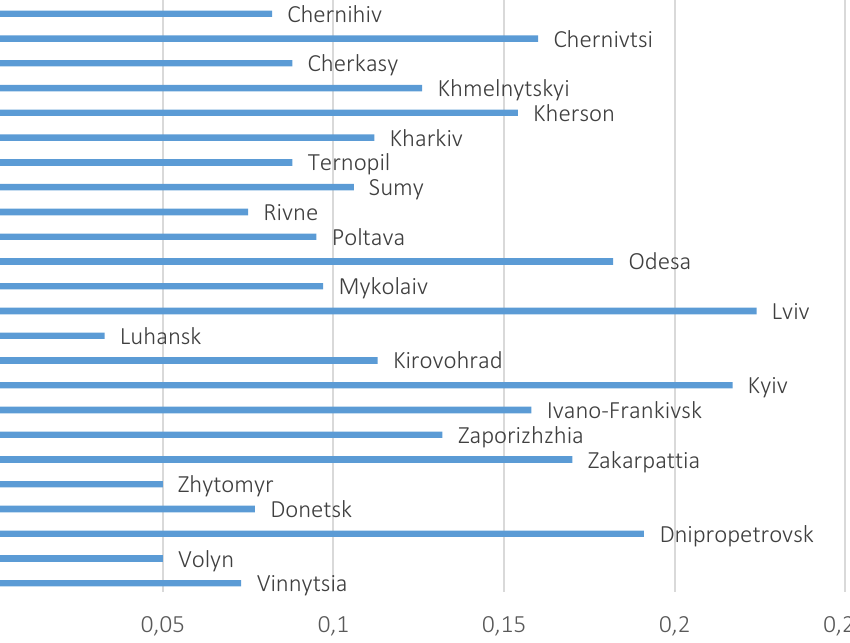
Figure 5. Polycriterial indicators of the Ukrainian region’s social effectiveness